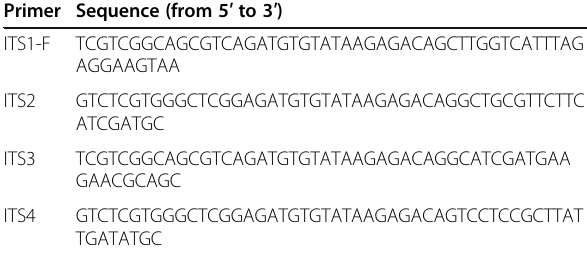
Table 2 Nucleotide sequence of the primers used for library preparation Primer Sequence (from 5 ′ to 3 ′